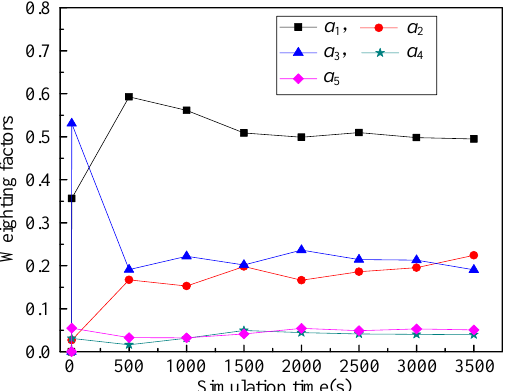
Figure 12. Relationship between weighting factors and simulation time: node 319.